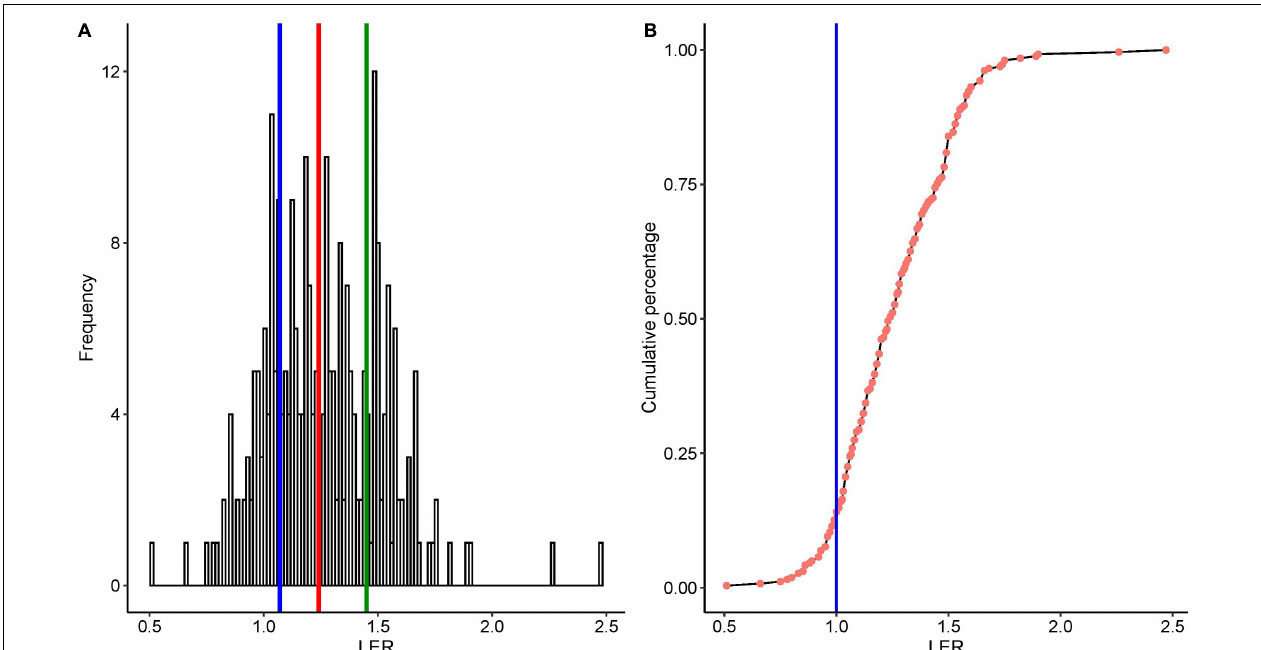
FIGURE 2 | (A) Frequency distribution of LER from 35 studies, quartiles marked by blue and green; median marked by red-colored vertical lines; (B) cumulative percentage distribution of LER from 35 studies, 36 (datasets); the vertical blue line in panel (B) shows LER = 1.